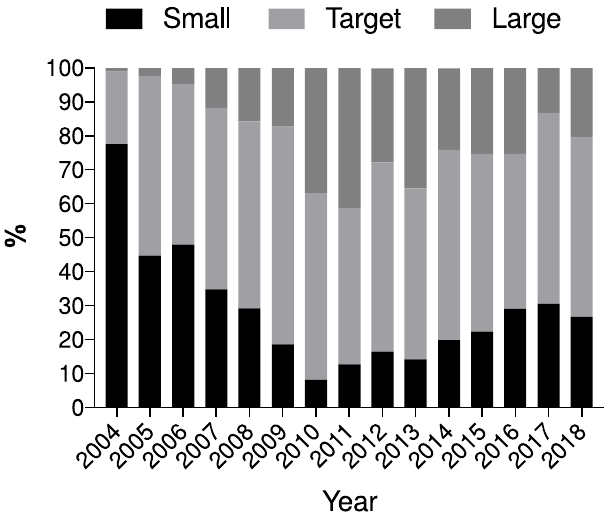
Fig. 5. Population structure of oysters ( Ostrea edulis ) caught in the annual population surveys. Data are presented as the percentage in each shell height size category of pooled data for all sites in surveys carried out 2004 – 2018. Black bars: small oysters below minimal legal size; Light grey bars: targeted oysters above minimal legal size and below preferred marked-size; Dark grey bars: large oysters above preferred marked size (see text for more details).